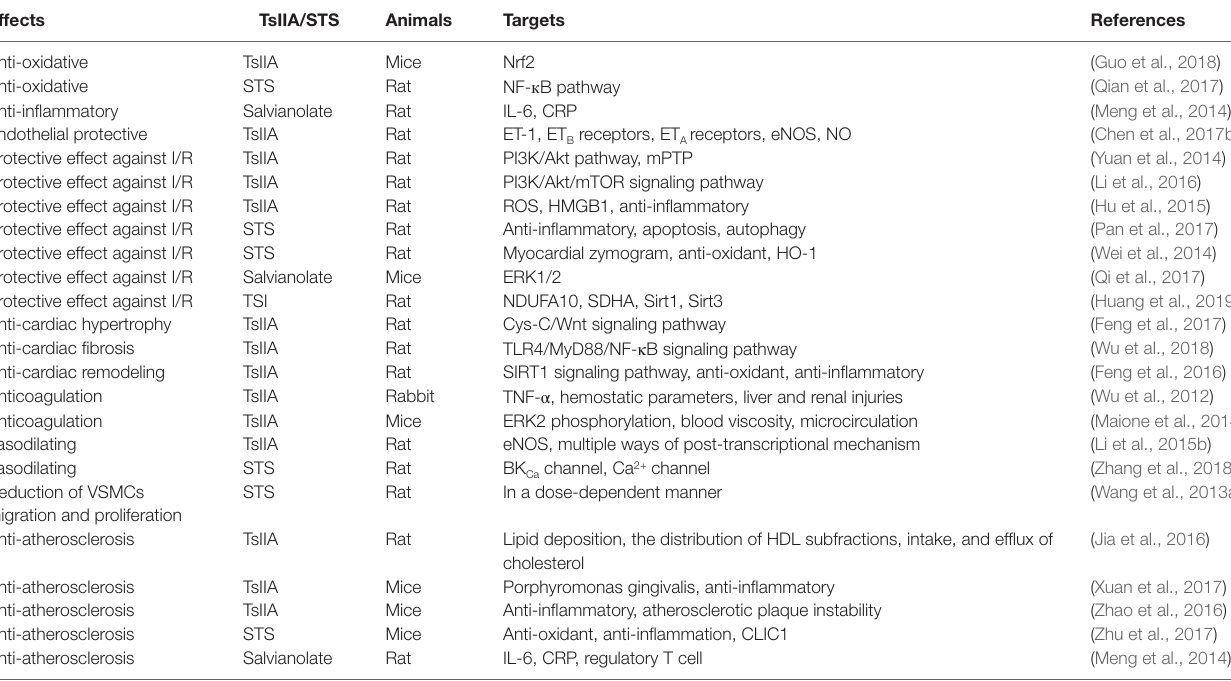
TABLE 2 | In vivo cardiovascular effects of TsIIA, STS, and